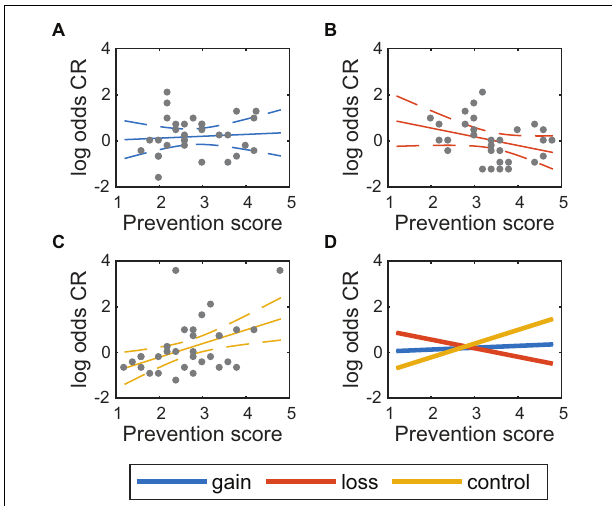
FIGURE 7 | Initial correct rejection rate varies with prevention score. Initial log odds correct rejection (CR) is shown vs. prevention score for (A) gain condition, n = 31, (B) loss condition, n = 30, and (C) control condition, n = 32. Solid lines show the expected mean, and dashed lines show a 95% confidence region around the expected mean. (D) Expected means for all three